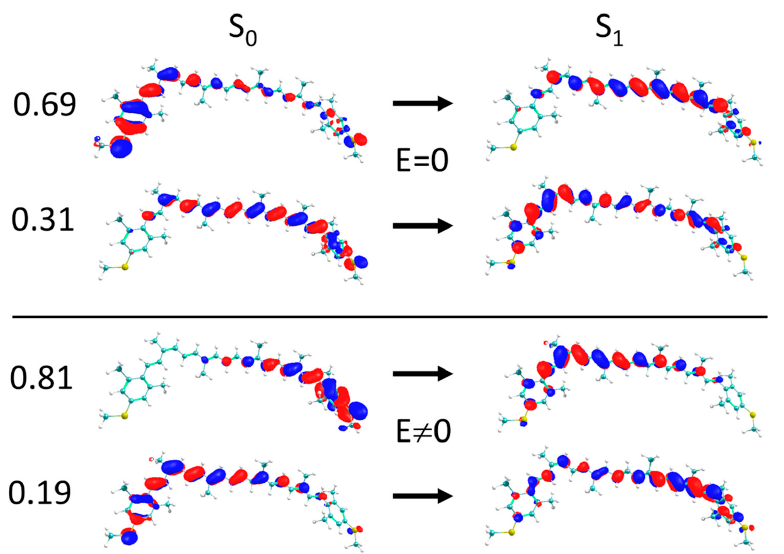
Figure A3. ( a ) Energy of the ground (solid lines) and first singlet excited (dashed) states along the rotation of the C–C double bond connecting cis-TMC and trans-TMC configurations. ( b ) Stabilisation of the S 1 state due to the inclusion of an EEF of 2.2 × 10 − 4 a.u. in the z direction. Blue and red colours correspond to positive and negative signs for the field.